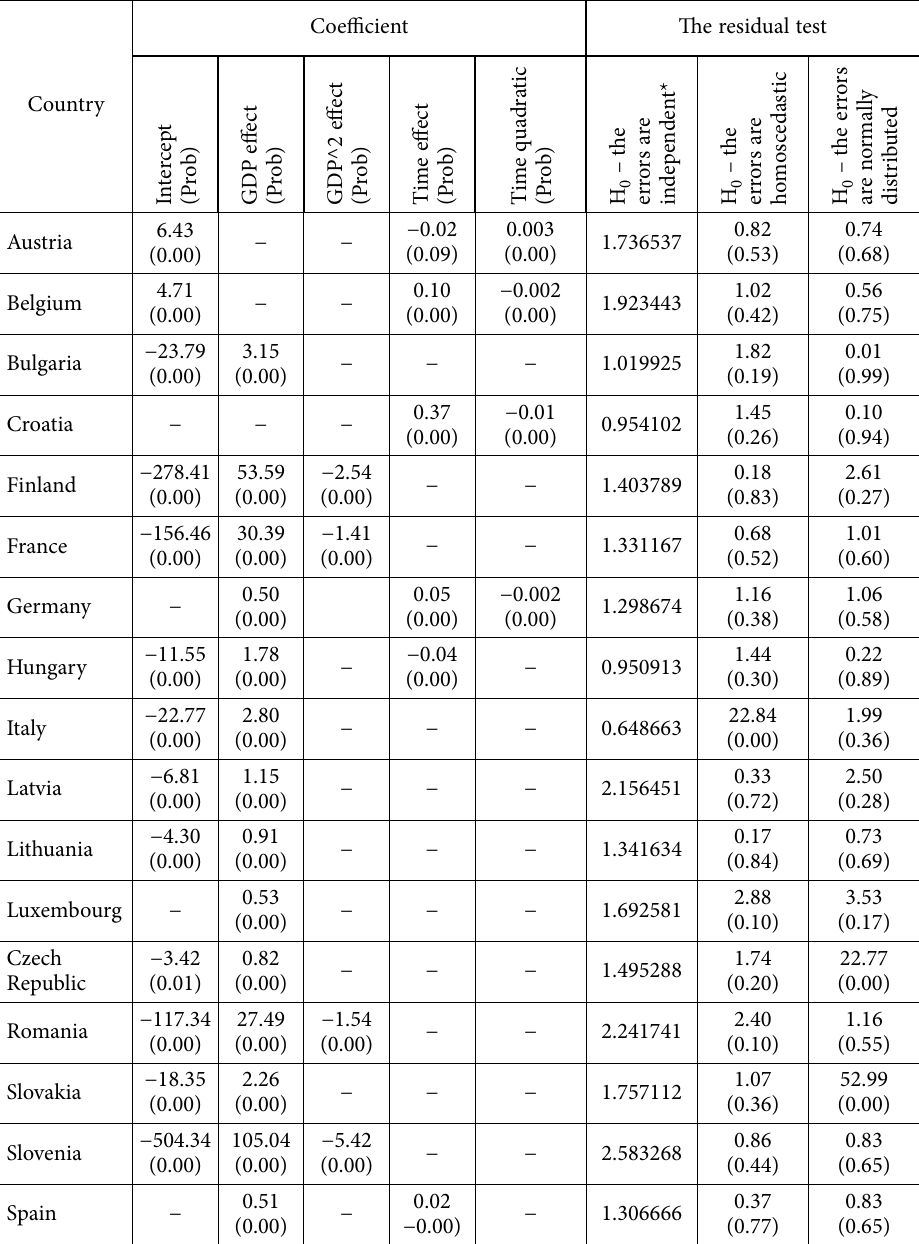
Table 4. OLS regression results – Dependent variable: Environmental protection expenditure − Special- ized providers (public and private)